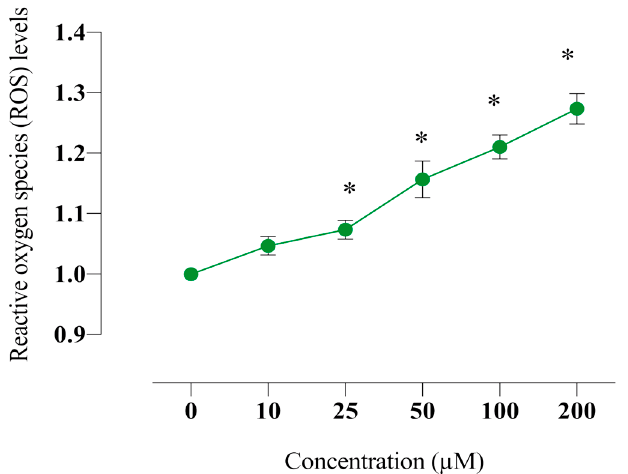
Figure 5. Measurement of intracellular ROS level in HeLa cells. The cells were stained with the ROS red dye, and spectrofluorimetric assay was performed to determine the intracellular ROS. A 25 µM dose of compound E inhibited CAIX and increased intracellular ROS level in a dose-dependent manner. The data are presented as the mean ± SD (n = 3). * p < 0.05 compared with the control.